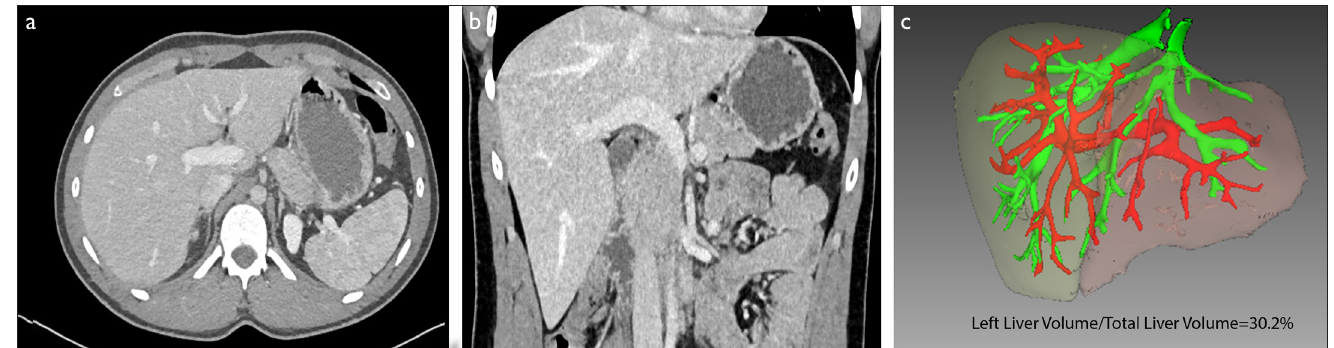
Figure 1. a-c. Axial (a) and coronal (b) computed tomography images of a patient with a normal liver. In the 3D volumetric evaluation(c), the ratio of the left lobe volume to the total liver volume was calculated as a